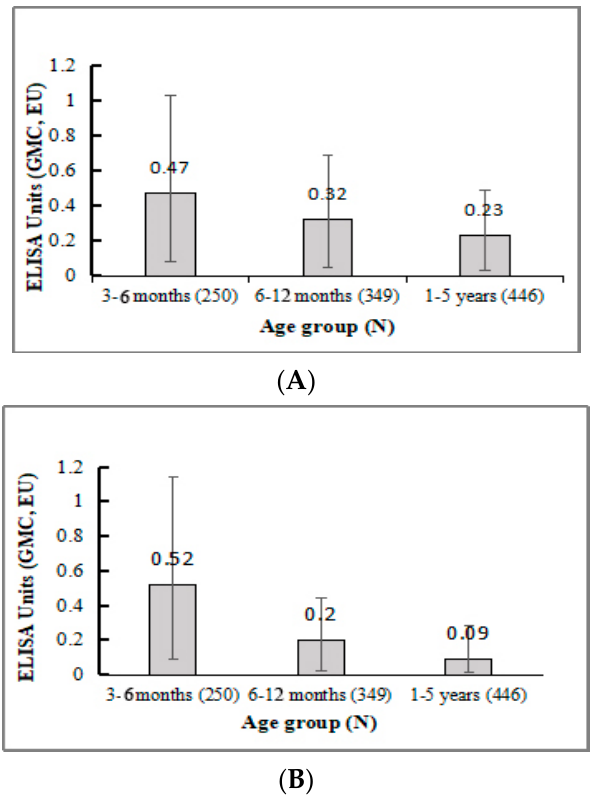
Figure 3. Pre ‐ vaccination GMC anti ‐ LPS IgG in all participants. ( A ). S. flexneri 2a antibody levels at Figure 3. Pre-vaccination GMC anti-LPS IgG in all participants. ( A ). S. flexneri 2a antibody levels at day 0. ( B ) S. sonnei antibody levels at day 0. day 0. ( B ) S. sonnei antibody levels at day 0. Table 2. Serum anti-LPS IgG levels in children aged 3–6 months old vaccinated with a half or full dose of the trial vaccine